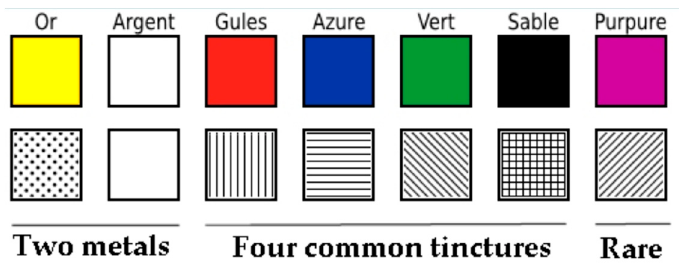
Figure 2. The metals and tinctures of heraldry, and the equivalent Petra Sancta system used by engravers.